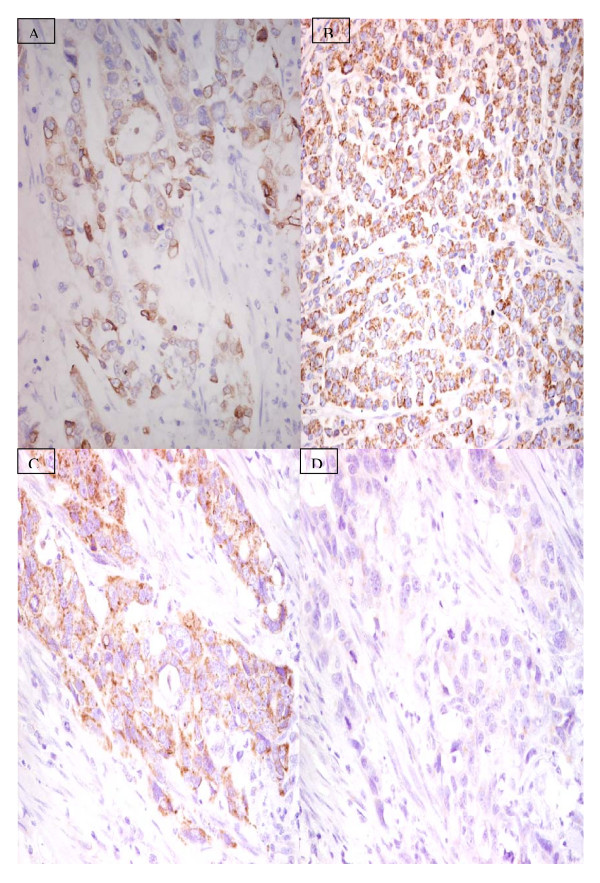
Representative examples of COX-2 immunhistochemistry in adenocarcinoma of oesophagus. (A) low level (<200) and (B) high level (>200)of COX-2 expression. Antigen adsorption study demonstrated good immunoreactivity with COX-2 antibody (C) and lack of immunoreactivity when staining was repeated in the presence of COX-2 blocking peptide (D).